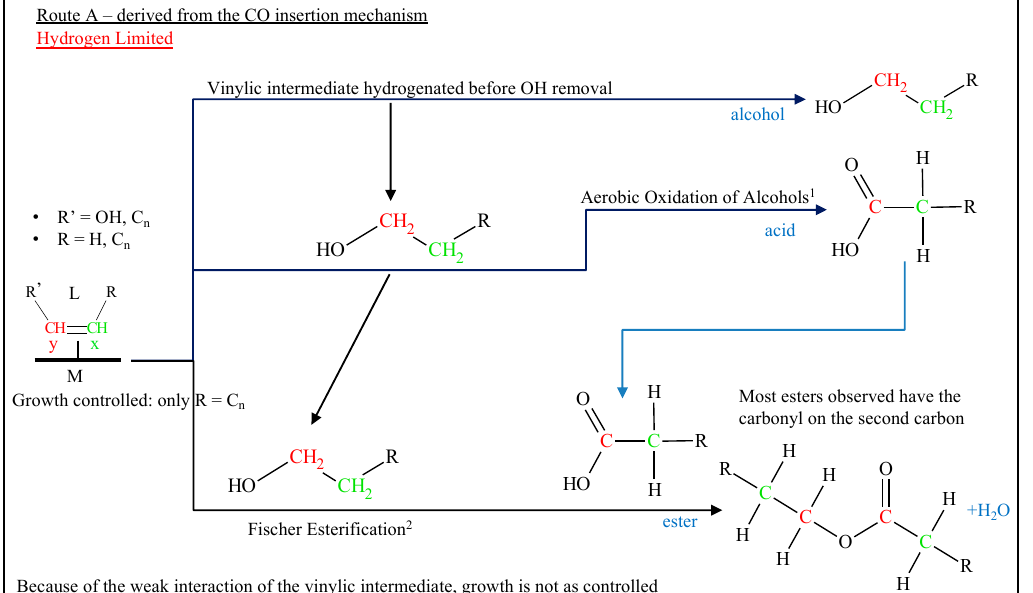
Figure 41. Proposed route A for the formation of several products observed in FTS, based on the CO insertion mechanism (Figure 38). This is the case where growth is somewhat controlled, but hydrogen is limited. However, given that growth occurs through CO insertion—alternative oxygenated materials could be made.